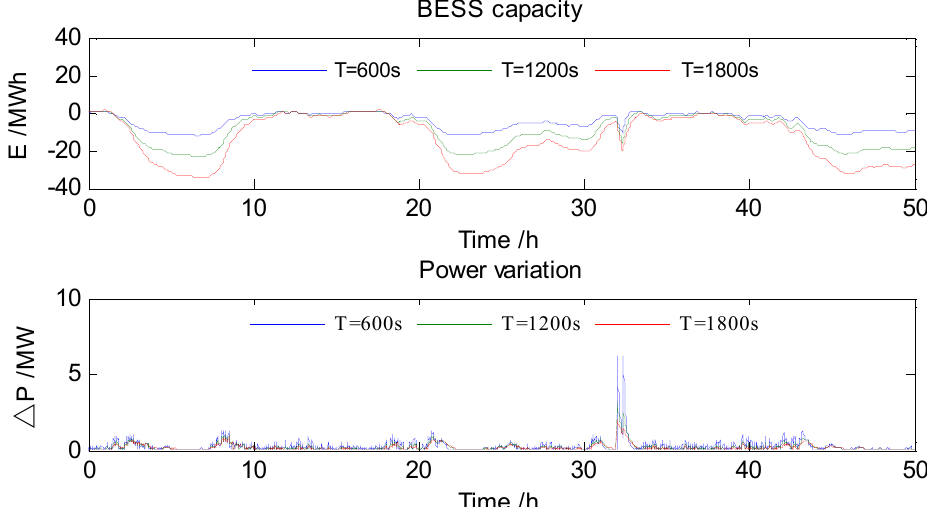
Figure 5. The relationship of the allocated capacity and power variation of BESS with the time constant T .